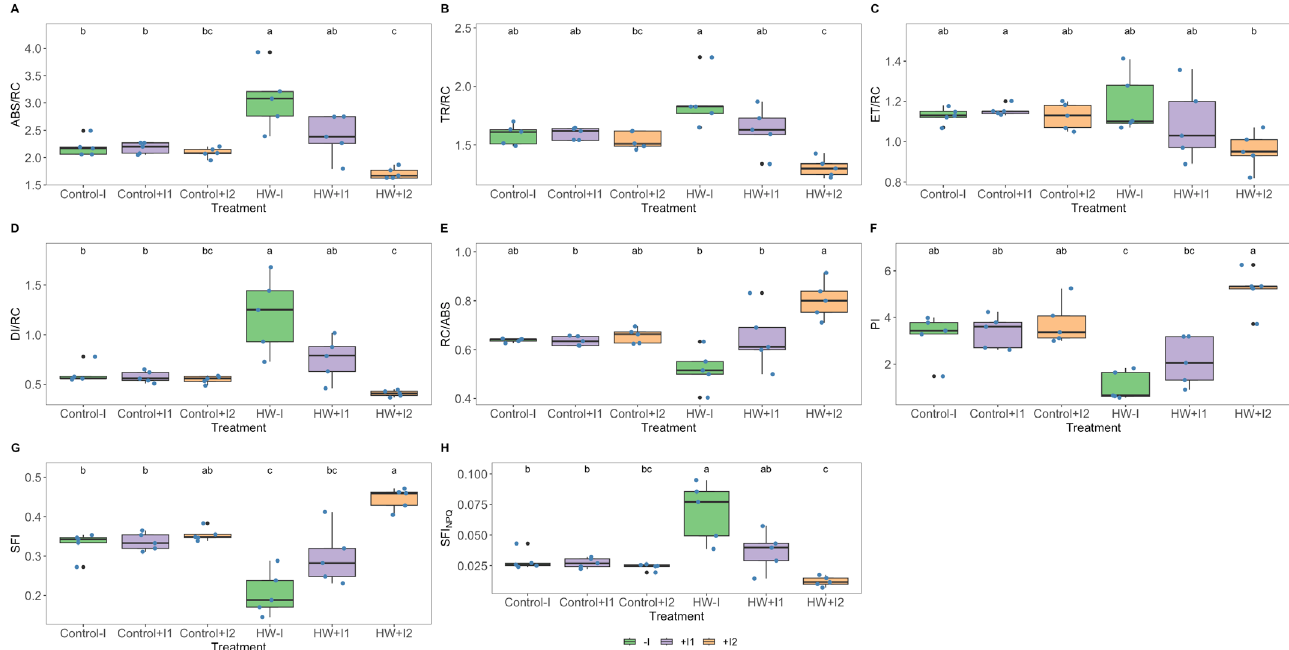
Figure 6. Reaction centre-based energetic parameters: ( A ) absorbed (ABS/RC), ( B ) trapped (TR/RC), ( C ) electron transport (ET/RC), ( D ) dissipation (DI/RC) energy fluxes by reaction centre and ( E ) reaction centre density within the PS II antennae (RC/ABS), ( F ) performance index (PI), ( G ) structural and functional index for photosynthesis (SFI), ( H ) non-photosynthetic or dissipation structural and functional index (SFI NPQ ) in non-inoculated ( − I) and marine PGPR consortia 1- and 2-inoculated (+I) Vitis vinifera dark-adapted leaves, under normal (control) thermal regimes and exposed to the heatwave (HW) (average ± standard deviation, N = 5, letter denotes significant differences at p < 0.05).